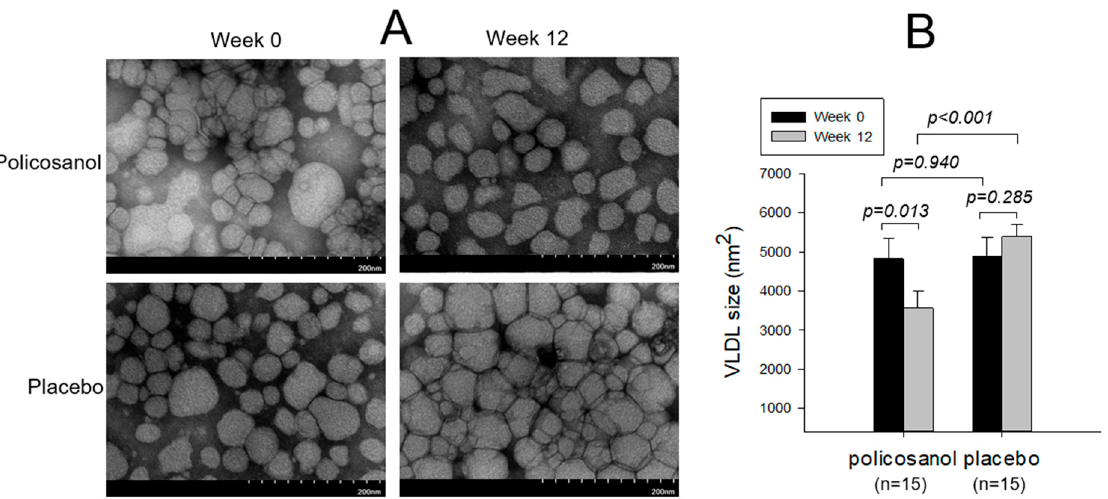
Figure 1. TEM image of VLDL ( A ) at a magnification with 40,000 × and area analysis ( B ) of VLDL from each group between weeks 0 and 12. VLDL particle size in each group between weeks 0 and 12 was compared by the paired t -test. One graduation of the scale bar indicates 20 nm. Table 3. Lipid compositions, oxidized extent, and extent of VLDL and LDL glycation between the policosanol and placebo